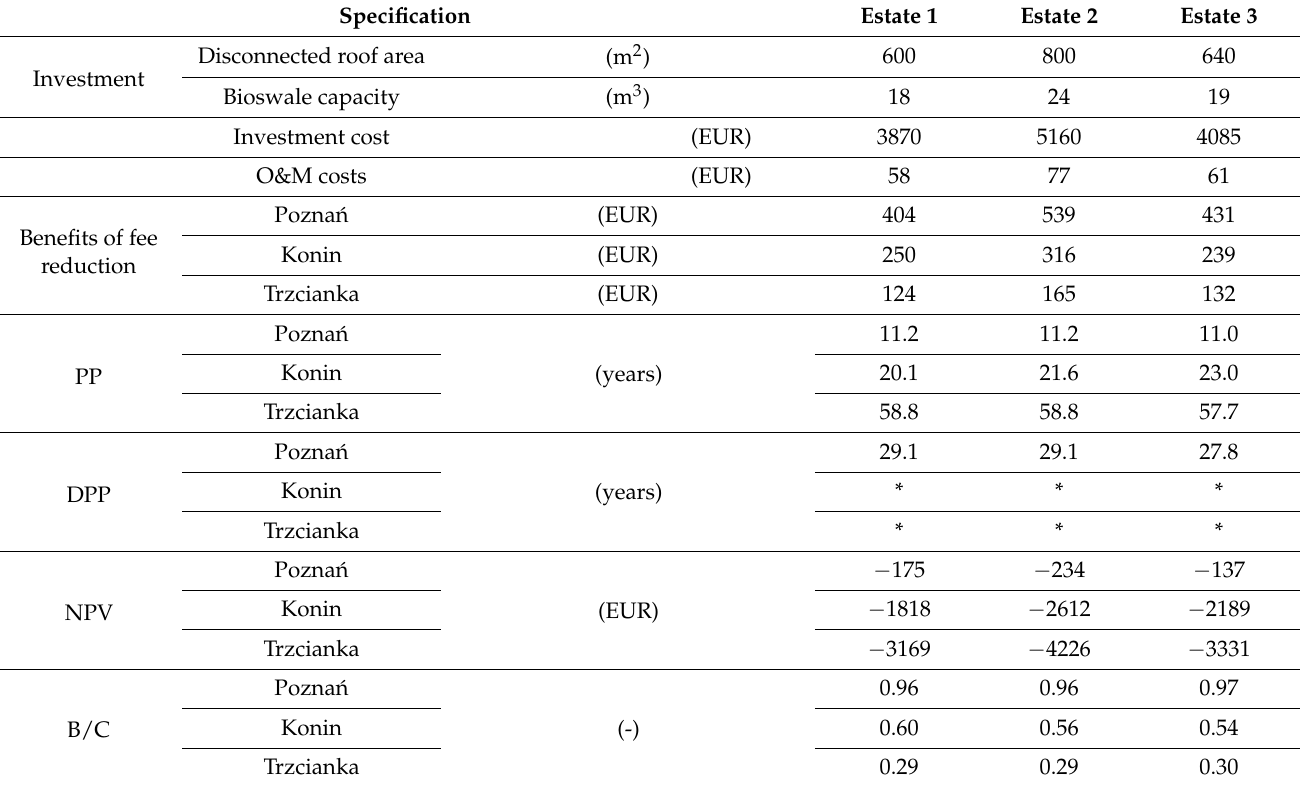
Table 16. Evaluation of the profitability for disconnecting 20% of the roof area.